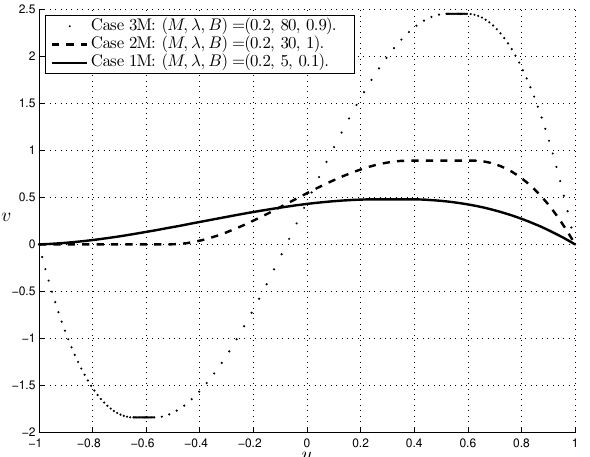
Figure 13. Profile of the velocity in the three